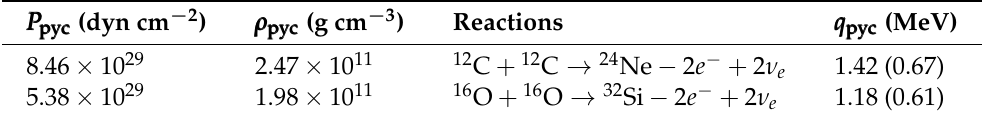
Table 6. Same as Table 5 for B (cid:63) =